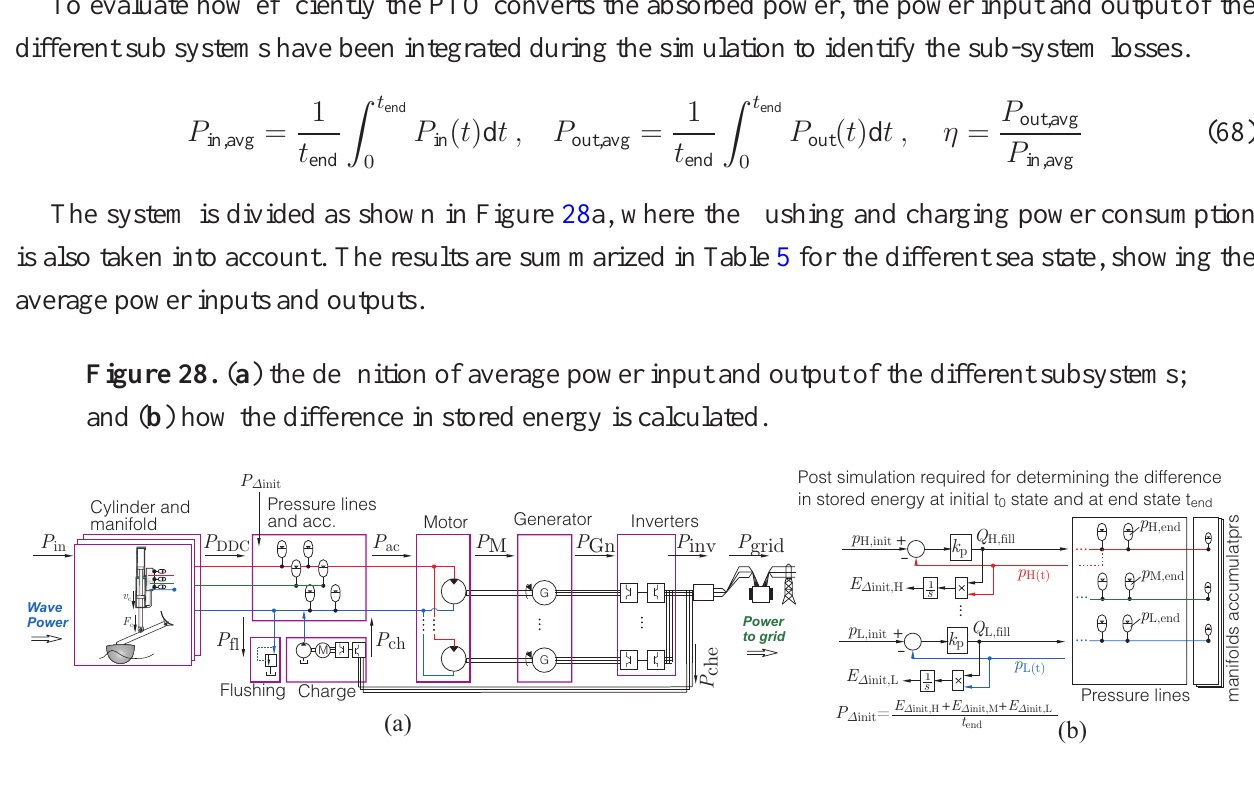
Table 5. Efficiencies of subsystems in Figure 28. SS1, SS2 and SS3 are abbreviations of the three tested sea states (1, 2,